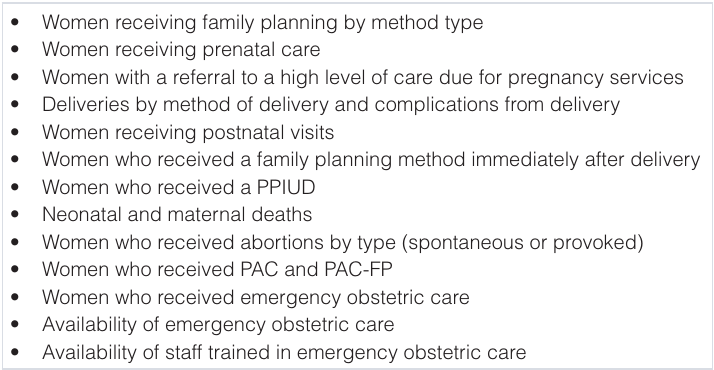
Table 2. Categories of information collected monthly in the revised “Report of Maternal and Infant Health”